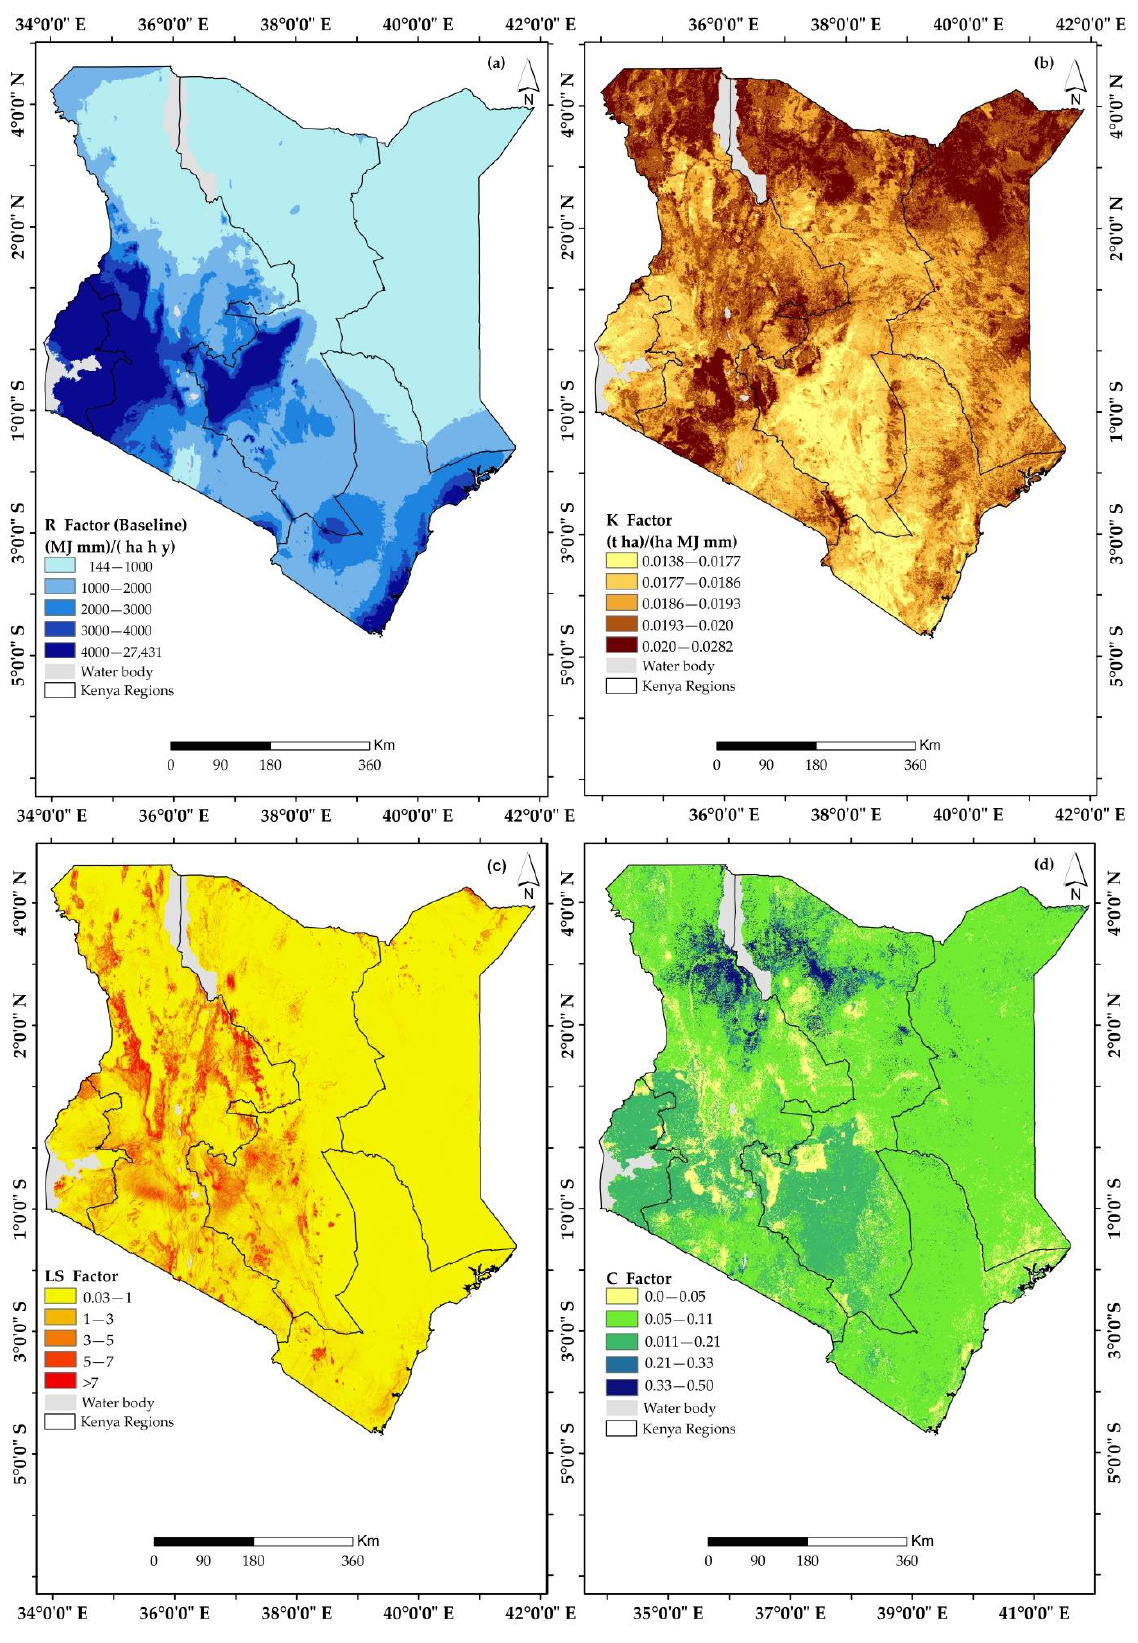
Figure 8. RUSLE parameters applied for soil erosion estimation in Kenya: ( a ) Rainfall-runoff erosivity; ( b ) Soil erodibility; ( c ) Terrain factor; ( d ) Vegetation cover factor.